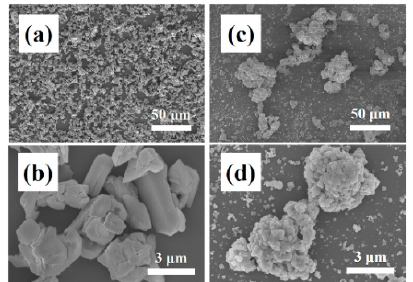
Figure 2. FE-SEM images of Y 2 O 3 and YF 3 powders before coating by aerosol deposition: ( a , b ) Y 2 O 3 powder and ( c , d ) YF 3 powder.